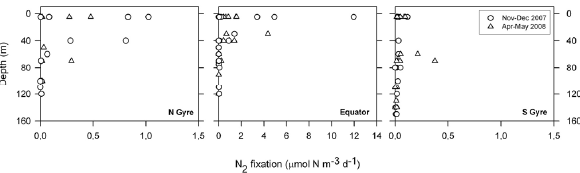
Fig. 8. Vertical distribution of N 2 fixation during the 2007 (trian- gles) and 2008 (circles) cruises in each latitudinal